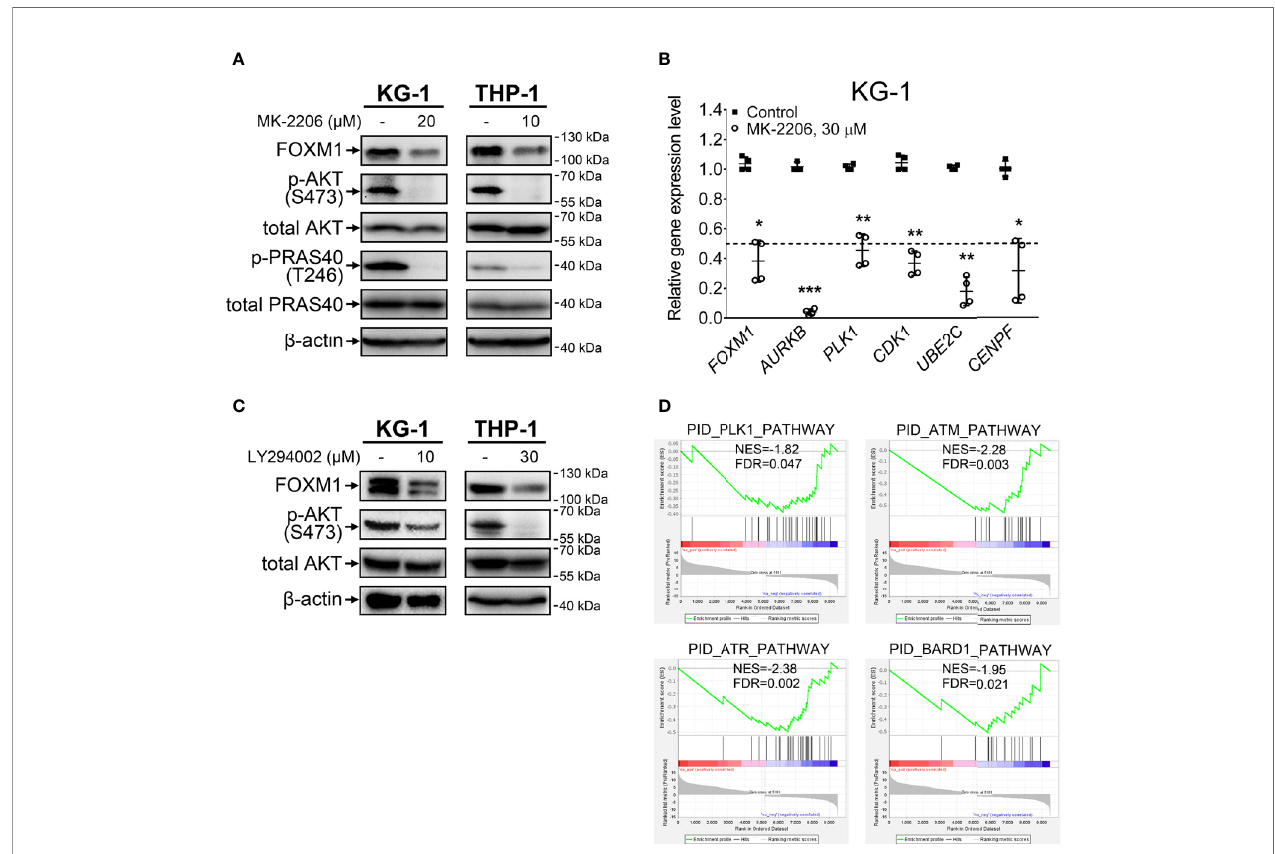
FIGURE 1 | FOXM1 expression is regulated by the AKT pathway in AML. (A) Direct inhibition of AKT with MK-2206 results in FOXM1 suppression. Cells were treated with indicated concentrations of MK-2206 for 24 hours, total protein samples were puri fi ed immediately after treatment and analyzed via immunoblotting with indicated antibodies, b -actin was used as an internal loading control. (B) AKT inhibition causes downregulation of FOXM1 target genes expression. KG-1 cells were treated with 30 m M MK-2206 for 24 hours, total RNA was puri fi ed immediately after treatment and analyzed via RT-qPCR. Data are presented as individual data points and means ± S.D., statistical signi fi cance is evaluated for Log 2 -transformed data using two-tailed Student ’ s t-test with Welch ’ s correction (*p < 0.05, **p < 0.01, ***p < 0.001 for N = 4). (C) Inhibition of PI3K with LY294002 results in suppression of both AKT phosphorylation and FOXM1 levels. Cells were treated with indicated concentrations of LY294002 for 24 hours, total protein samples were puri fi ed immediately after treatment and analyzed via immunoblotting with indicated antibodies, b -actin was used as an internal loading control. (D) MK-2206 treatment of KG-1 cells suppresses genetic signatures of FOXM1 target PLK1 and DNA damage response regulators. KG-1 cells were treated with 30 m M MK-2206 for 24 hours, total RNA was puri fi ed immediately after treatment and analyzed via RNA-seq. NES, normalized expression score; FDR, false discovery